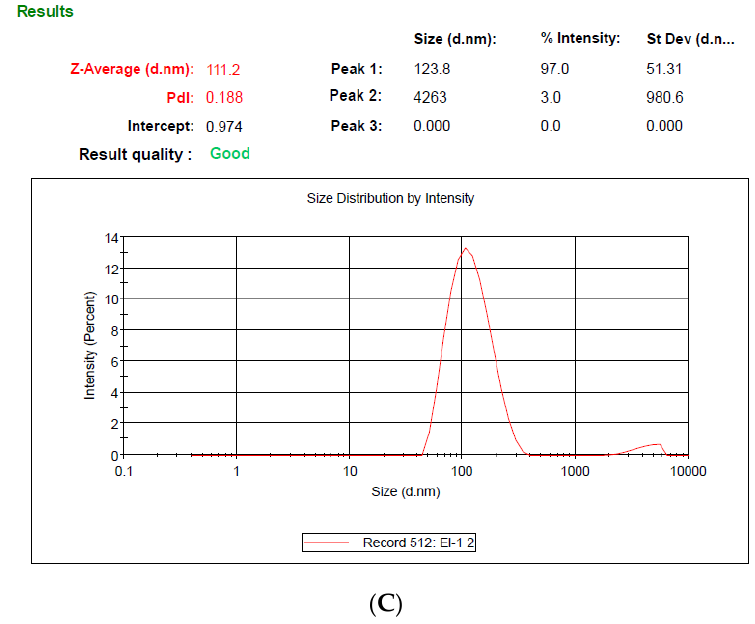
Figure 1. Particle size distribution of( A )phosphate buffer saline (PBS) reconstituted elastic lipo- somes,( B )bovine serum albumin (BSA)-loaded elastic liposomes (BSA-elastic liposomes (EL)), and( C ) Plasmodium falciparum asexual blood-stage surface antigen fusion protein ( Pf MSP-Fu 24 )- laden elastic liposomes (EL- Pf MSP-Fu 24 ). Size was measured using zeta sizer (Malvern) and a sin- gle peak with 100% intensity at 137.1, 174.6, and 123.8 nm was seen for PBS, BSA, and Pf MSP-Fu 24 - loaded elastic liposomes, respectively. Polydispersity index was calculated to be 0.074, 0.102, and 0.188 for PBS, BSA, and Pf MSP-Fu 24 -loaded elastic liposomes formulations, respectively. Size and PDI of EL formulations were measured by Malvern, zeta-sizer at the ILS, Ahmedabad. The mean diameters of PBS, BSA,and Pf MSP-Fu 24 -loaded ELs were estimated to be 137.1, 174.6,and123.8nm, respectively (Figure 1).Our results showed unilamelarity